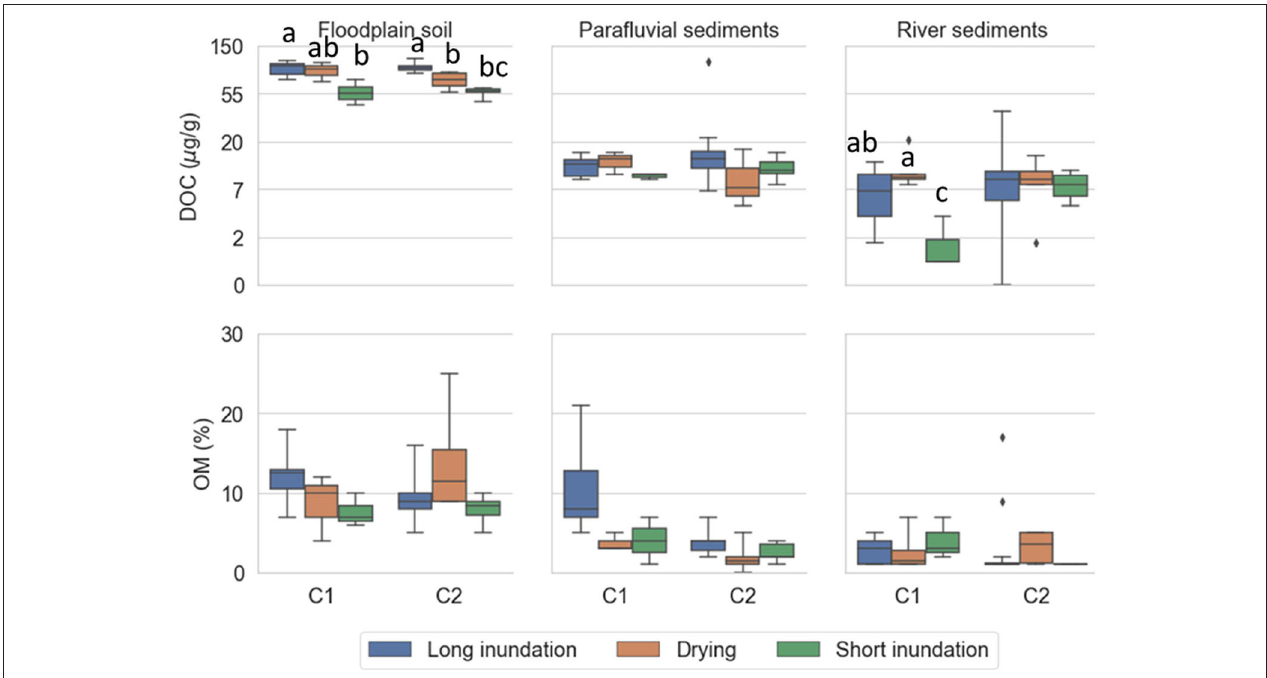
FIGURE 4 | DOC and OM content in soil and sediment extracts per site (floodplain soil, parafluvial sediments, river sediments) for each phase (long inundation, drying phase, short inundation phase). The data is aggregated by cycle (cycle 1 and 2). For each cycle, the treatment cores were subject to drying (orange; n = 6) and short inundation (green; n = 6) events. The control cores (blue; n = 12) were kept flooded throughout the entire experiment and were equally sampled at the same dates as the treatment cores. DOC concentration was pseudo log transformed for better visibility of range. Error bars are the 95% confidence interval, the bottom and top of the box are the 25th and 75th percentiles, the line inside the box is the 50th percentile (median), and any outliers are shown as